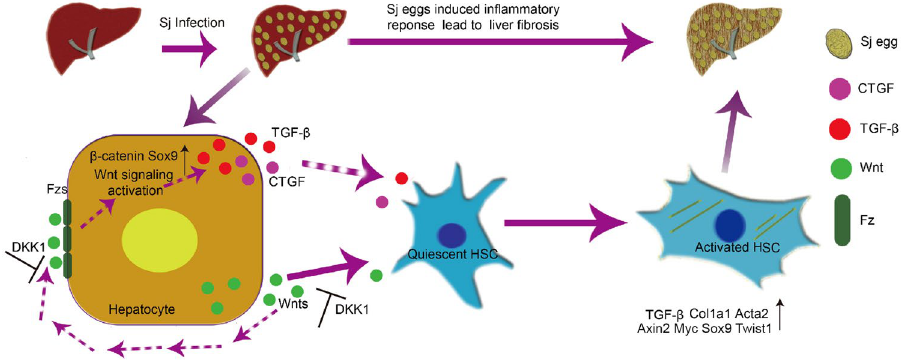
Figure 7. Enhanced Wnt signalling in hepatocytes contributes to liver fibrosis induced by S. japonicum infection. During the development of Schistosomiasis liver fibrosis, Enhanced Wnt signalling of hepatocytes promotes liver fibrogenesis. In addition, S. japonicum infection accelerates the expression of pro-fibrogenic factors TGF- β and CTGF in hepatocytes, which is controlled by Wnt